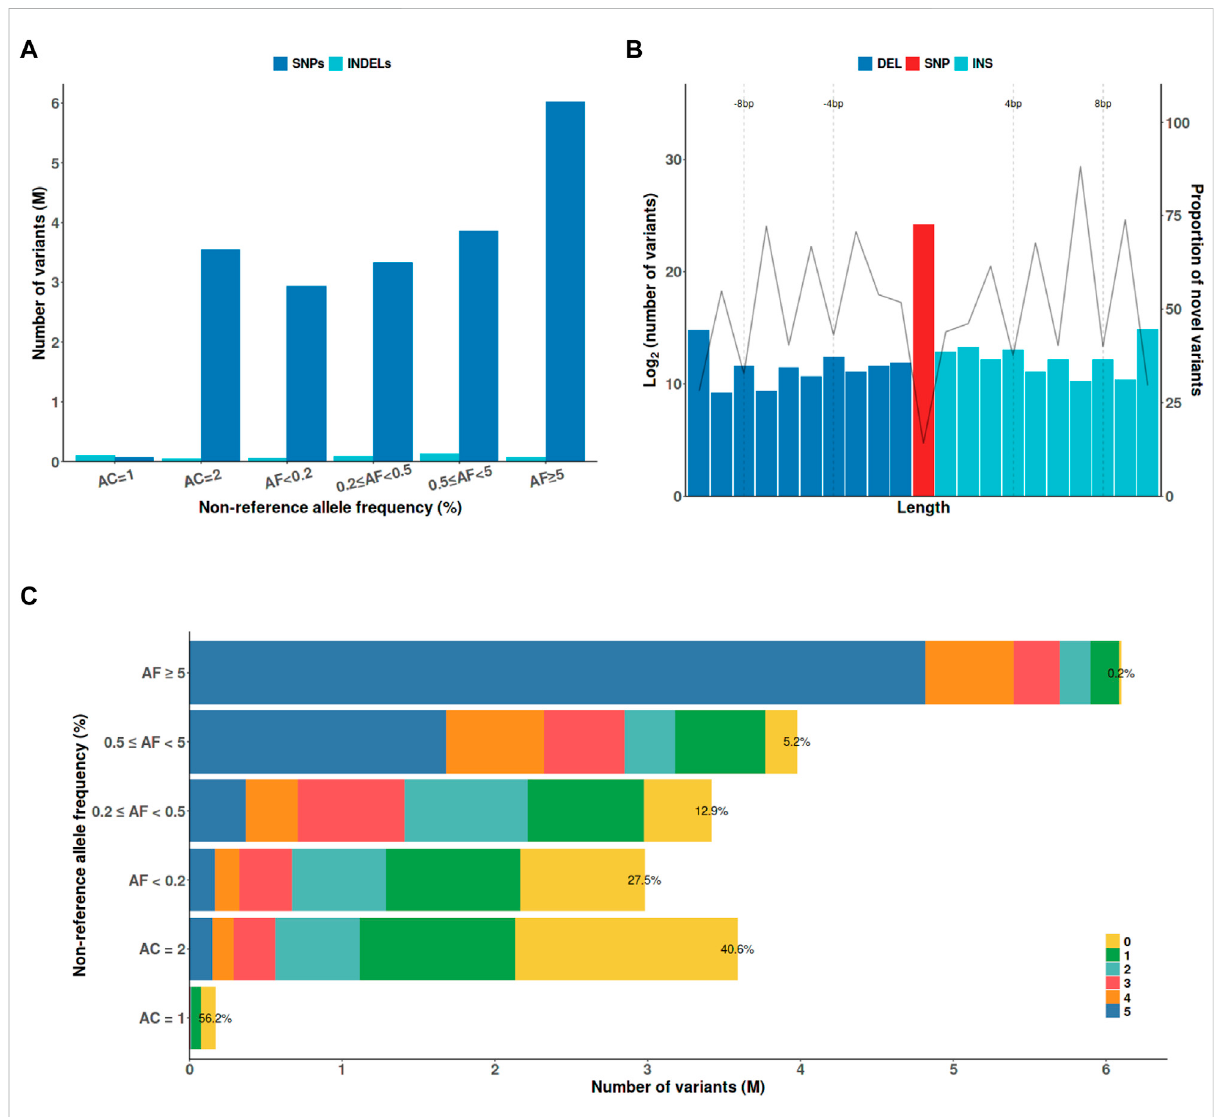
FIGURE 1 ThecharacteristicsofgeneticvariantsdiscoveredbytheKRGproject. (A) The x -axisindicatesthenon-referenceAF. (B) Variantswerede fi nedas novel if they were not present in the other whole-genome sequencing datasets (1KGP3, HRC, TOPMed, GAsP, and ChinaMAP). (C) The numbers indicate the number of ther other whole-genome sequencing datasets that contained a variant with the indicated AF; ‘ 0 ’ indicates that a variant was only found in the KRG panel. Abbreviations: AC, allele count, AF, allele frequency; DEL, deletion; INDEL, insertion/deletion; INS, insertion; SNP, single-nucleotide polymorphism; KRG, Korean Reference